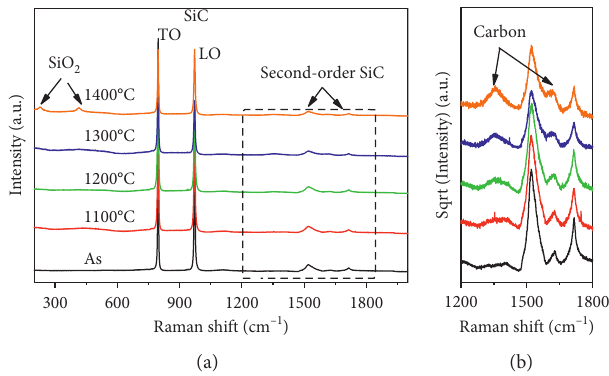
Figure 5: Raman spectra of TRISO particles. (a) Both as-deposited sample and the samples after air oxidation at 1200 ° C–1400 ° C for 24 h and (b) amplified Raman spectra from 1200cm − 1 –1800cm − 1 .